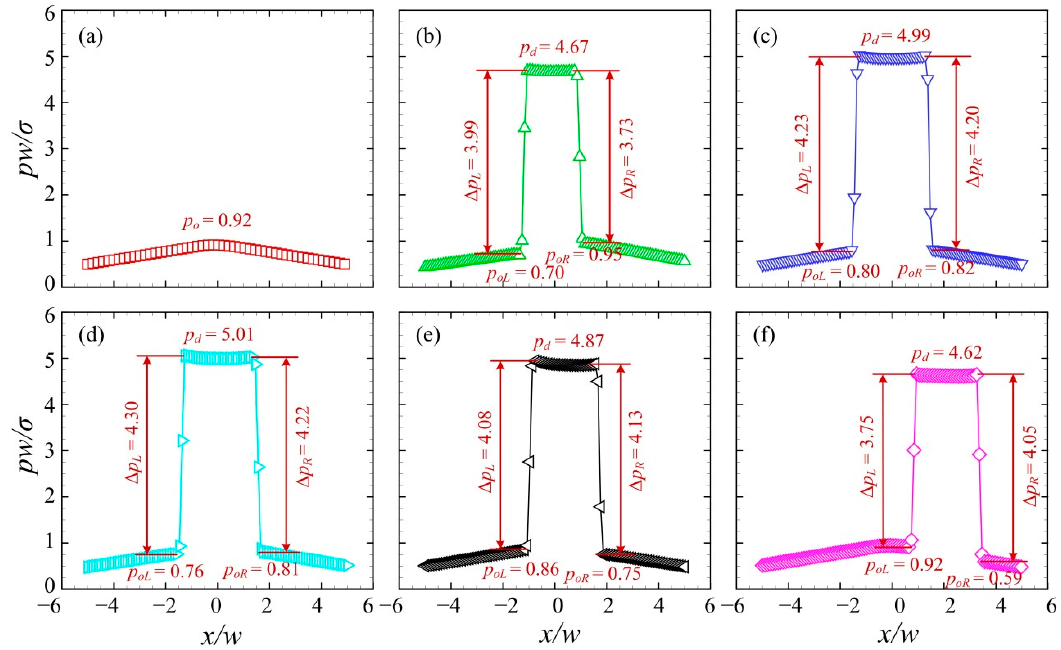
Figure 11. Pressure distributions along the centreline of the branching channels when the droplet is sorted into the right channel at U = 4 mm/s ( θ = 40°, V d / w 3 = 2). ( a ) T0, ( b ) T1, ( c ) T2, ( d ) T3, ( e ) T4, ( f ) T5.